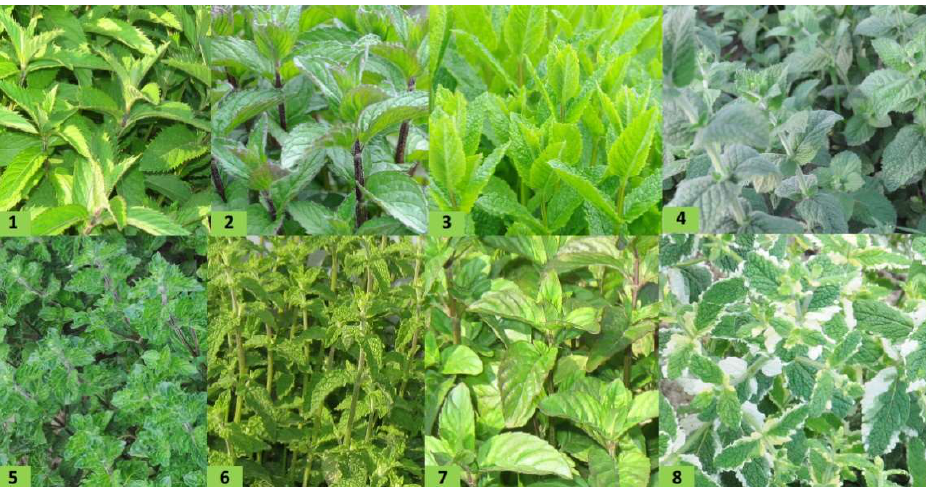
Figure 1. Mint plants used in the experiment: No. 1. Mentha × piperita ‘Swiss’, No. 2. M. × piperita ‘Multimentha’, No. 3. M. spicata ‘Morocco’, No. 4. M. rotundifolia, No. 5. M. spicata ‘Crispa’, No. 6.